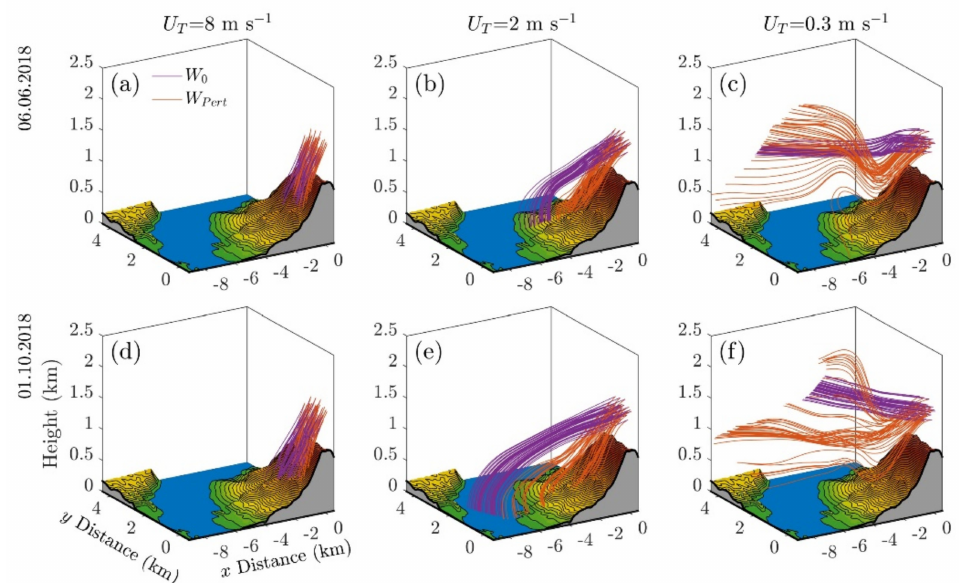
Figure 13. Sample particle trajectories for an injection height ( H I ) of 500 m agl for the June (first row) and October (second row) cases, using different particle terminal velocities ( U T ): ( a , d ), 8 m s –1 , ( b , e ), 2 m s –1 , ( c , f ), 0.3 m s –1 . Results are shown using a 0 m s –1 vertical velocity field ( W 0 ; purple lines) and the vertical velocity field output by WRF ( W Pert ; red lines). Trajectories were calculated only using data from the ∆ x = 50 m domain